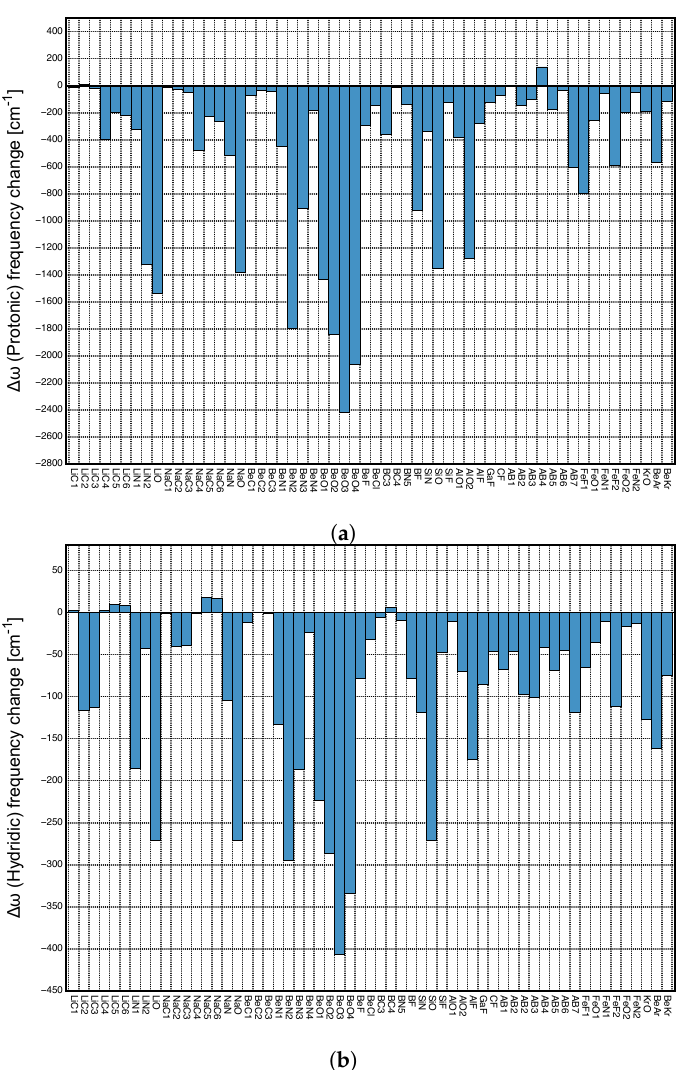
Figure 5. ( a ) Local mode frequency shifts ∆ ω of the protonic parts of DHBs. ( b ) Local mode frequency shifts ∆ ω of the hydridic parts of DHBs, where a positive sign denotes a blue–shift and a negative sign a red–shift. Figure 7a presents the relationship between protonic and hydridic local mode fre- quency shifts ∆ ω , and Figure 7b the relationship between the corresponding relative shifts ∆ ω / ω , involving Group I–Group IV